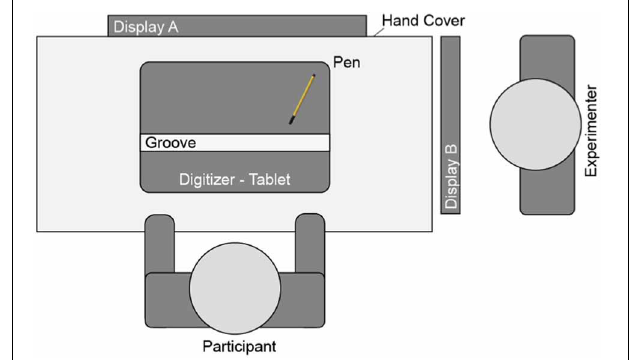
FIGURE 2 | Experimental setting.